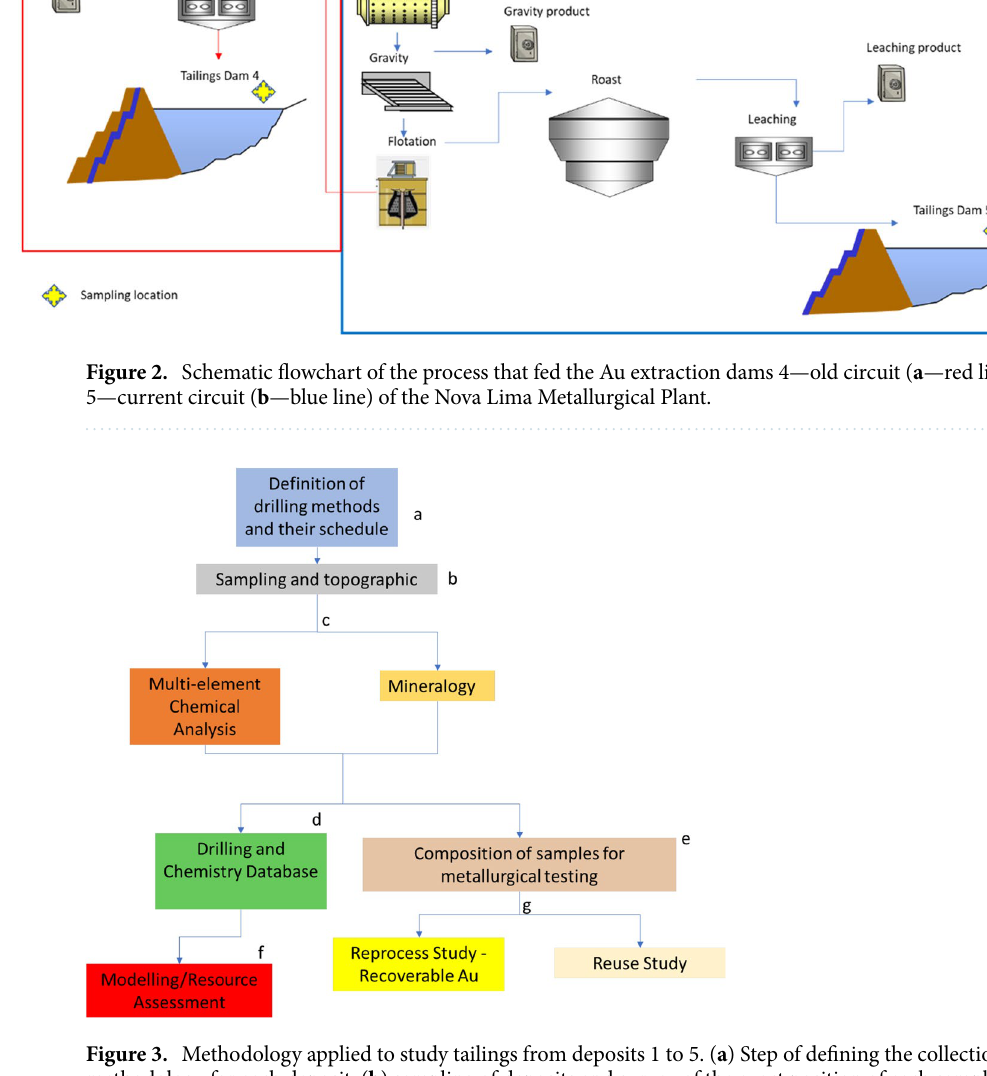
Figure 3. Methodology applied to study tailings from deposits 1 to 5. ( a ) Step of defining the collection methodology for each deposit, ( b ) sampling of deposits and survey of the exact position of each sampled point, ( c ) stage of collecting information on the about chemistry and mineralogy of the samples, ( d ) assembly of a database containing survey and characteristics of each sample, ( e ) 3D modelling and geostatistical analysis of information obtained from sampling, ( f ) composition of samples after 3D modeling for metallurgical tests e, ( g ) study of the potential extraction of Au and reuse of the tailings in its